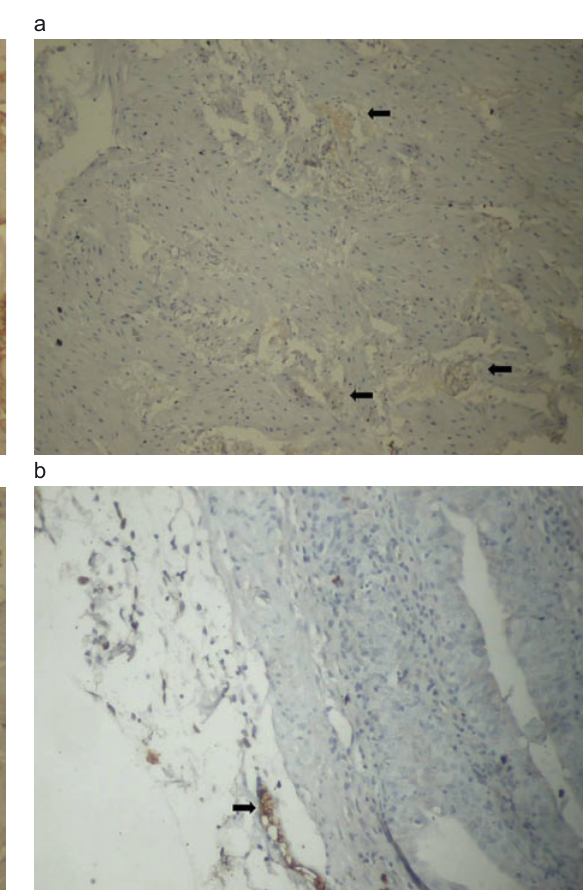
Figure 2. Strong (+++) c-kit expression of ICs in (a) normal bladder muscular layer in the control group and (b) weak (+) c-kit expression of ICs in bladder muscular layer of rabbits with diabetes (CD117, DAB x100). ICs: Interstitial cells.